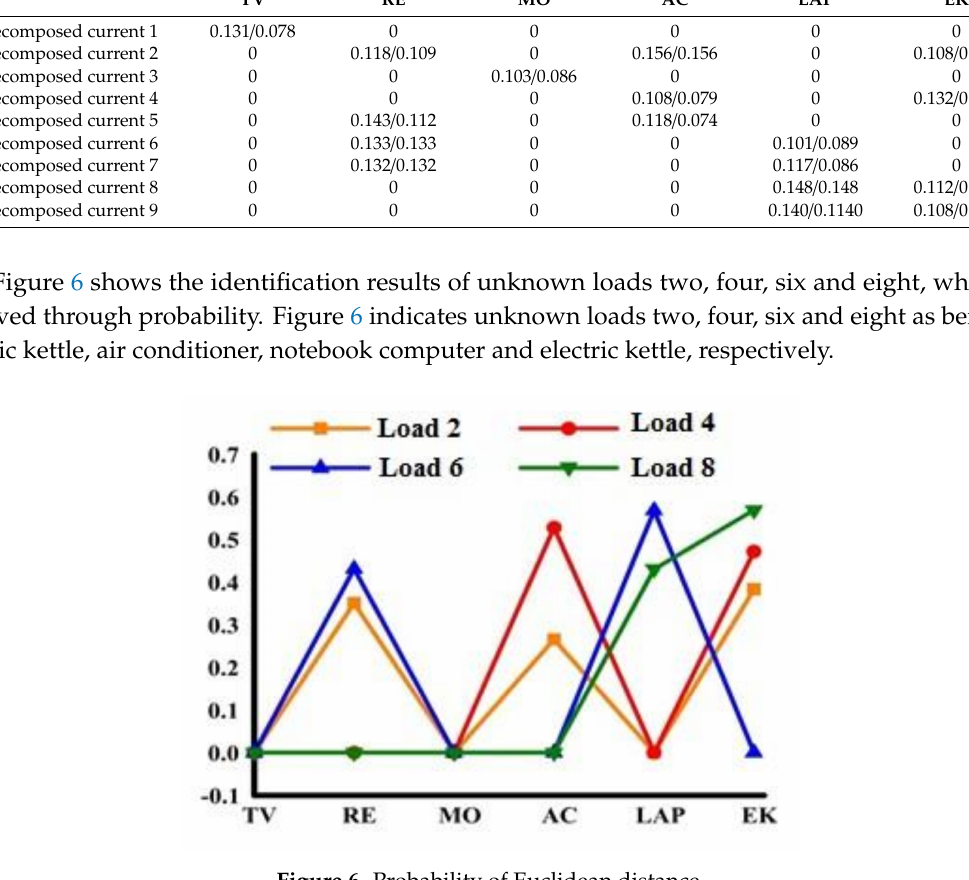
Figure 6. Probability of Euclidean distance.